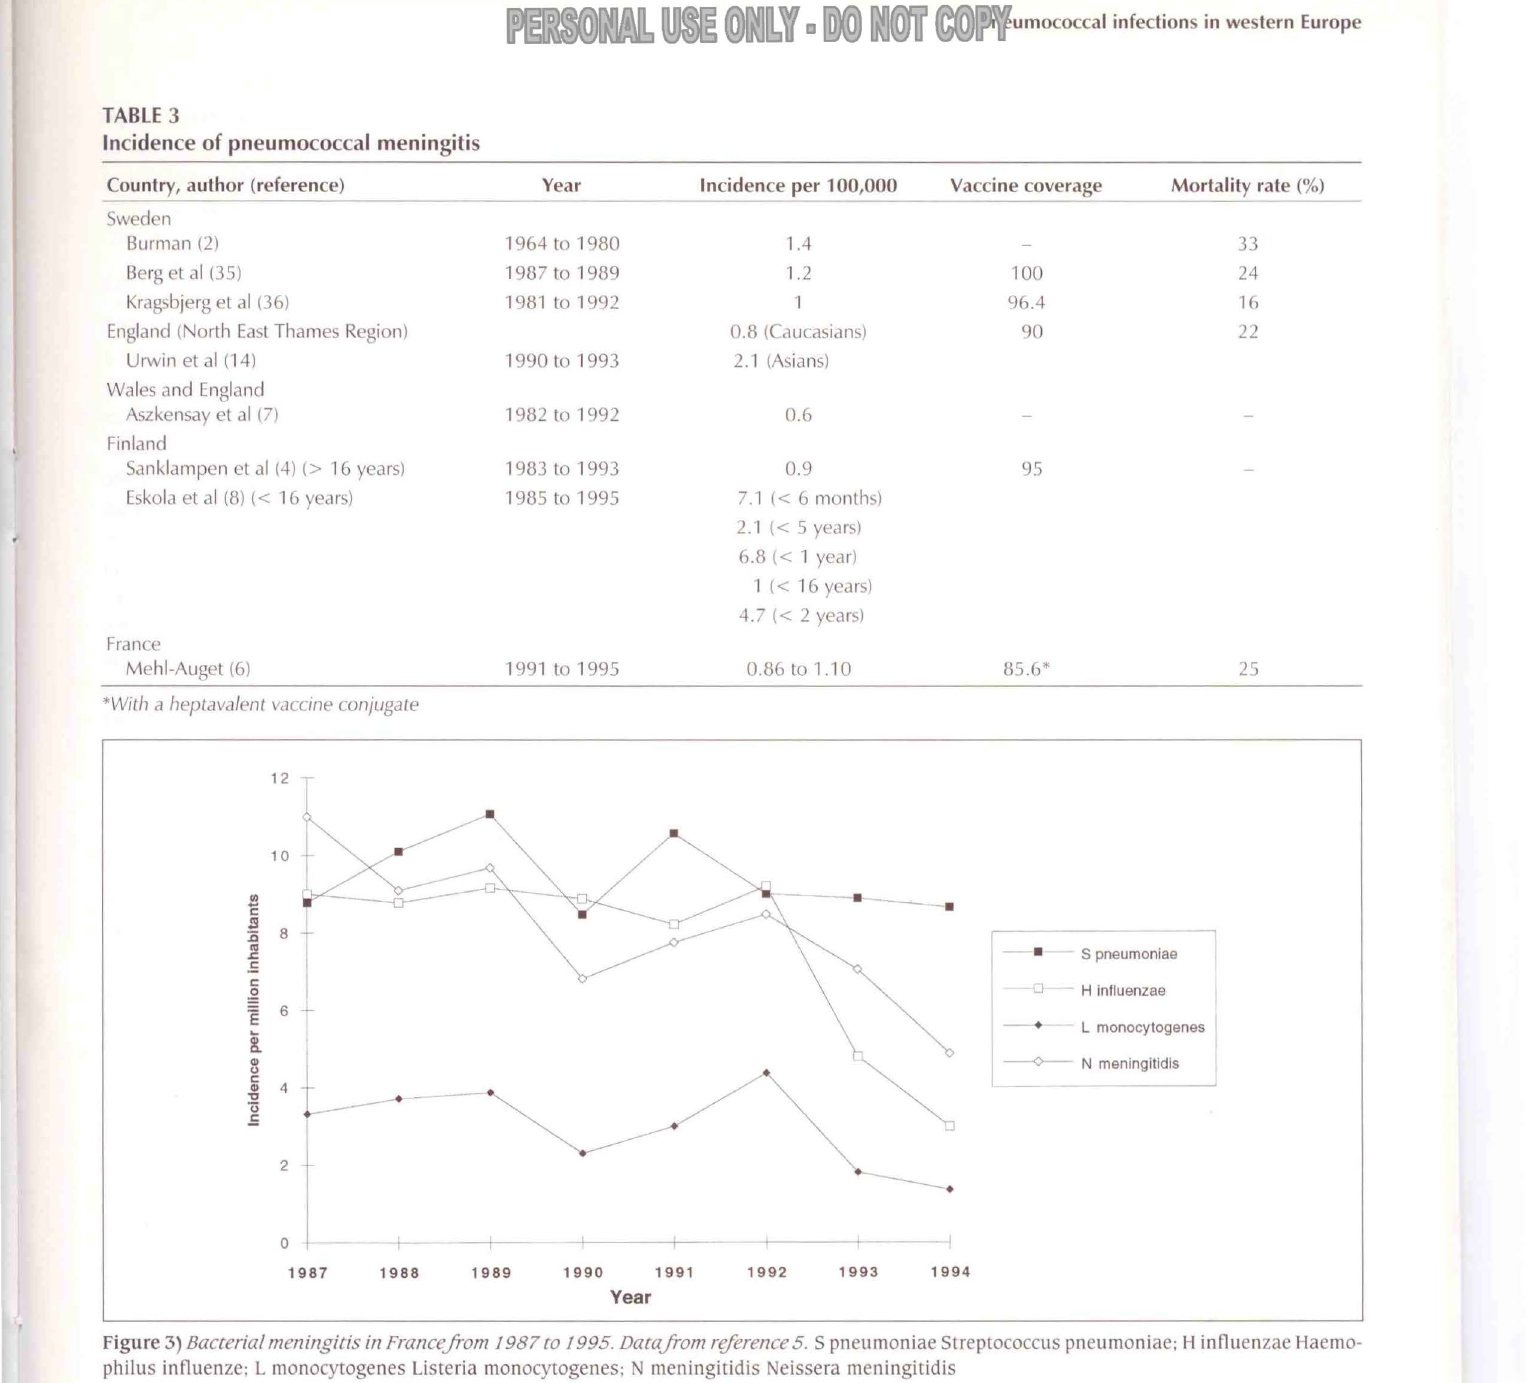
Figure 3) Bacterial meningitis in FranceJrom /987 to 1995. Data.from reference 5. S pneumoniae Streptococcus pneumoniae; H influenzae